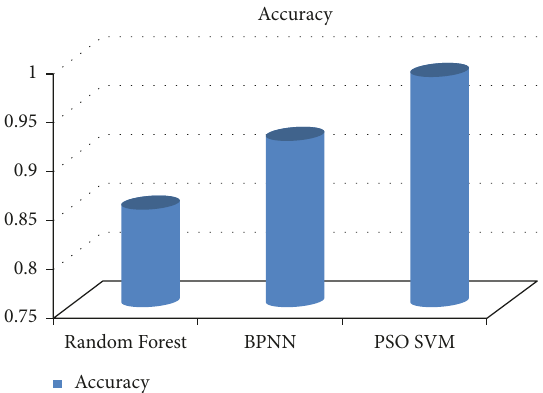
Figure 3: Accuracy of classifiers for grape leaf disease